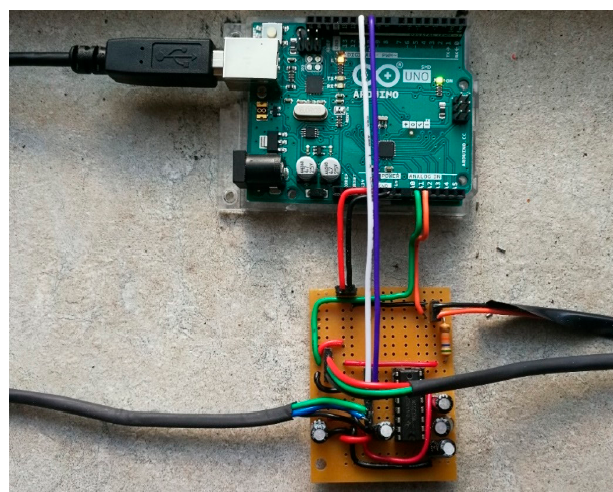
Figure 3. Weather data logger.